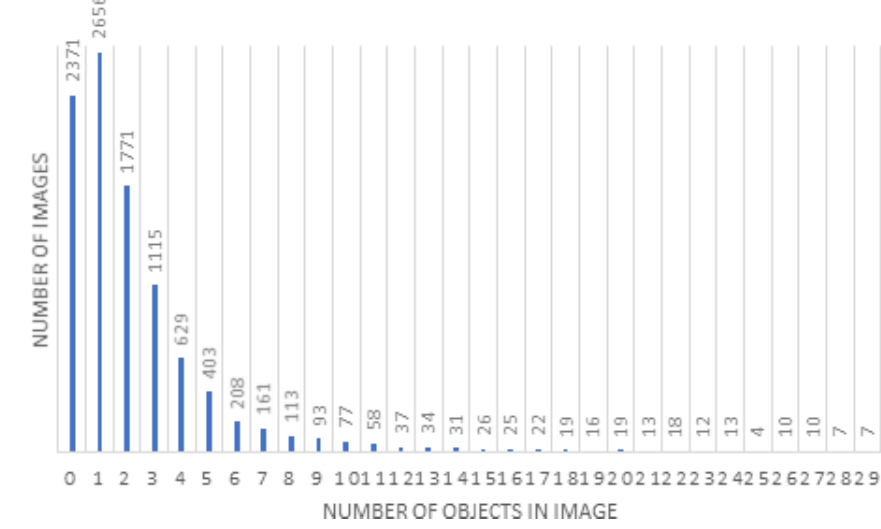
Figure 3. Average distribution of objects in images – data set with 10000 images.